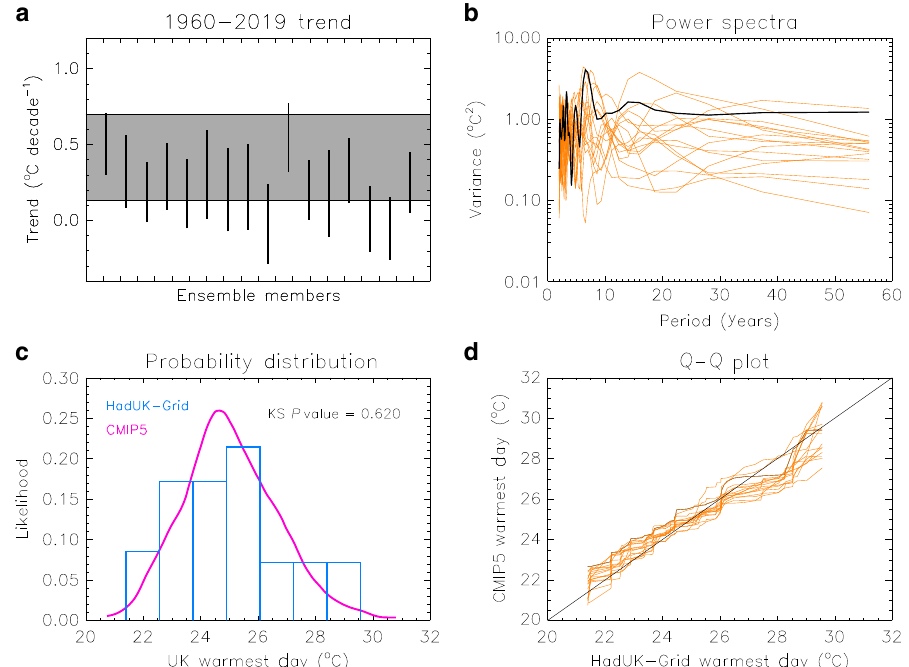
Fig. 3 Model evaluation. a The ±2 standard deviation range of the 1960 – 2019 trend (°C decade − 1 ) in the UK mean warmest daytime temperature ( tx01 ) estimated with HadUK-Grid observations (grey band) and CMIP5 model simulations with all forcings (vertical bars). b Power spectra from detrended timeseries of the UK mean tx01 computed with observations (black line) and model simulations (orange lines). c Normalised distributions of the UK mean tx01 in period 1960 – 2019 from observations (blue histogram) and aggregated data from the all-forcing simulations (pink line). The P -value of a Kolmogorov – Smirnov test that assesses whether the two distributions are signi fi cantly different is also shown. d Quantile – quantile (Q – Q) plots for each of the 16 models, comparing the simulated and the observed UK mean tx01